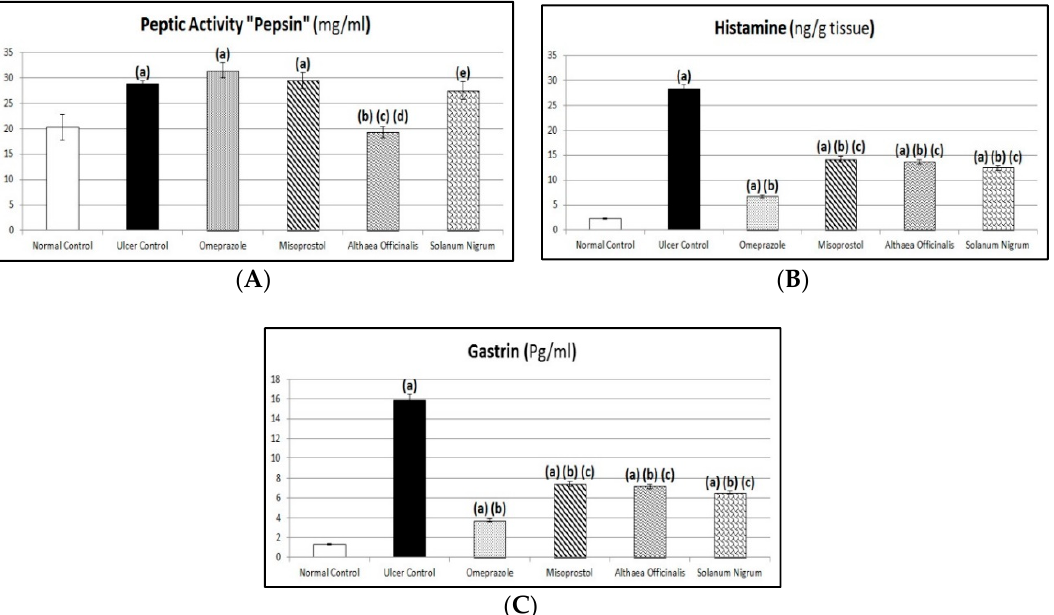
Figure 7. Protective effects of Althaea officinalis and Solanum nigrum with standards misoprostol and omeprazole on peptic activity ( A ), histamine ( B ), and gastrin ( C ) against pyloric-ligation/indomethacin-induced gastric-ulceration experimentally in male rats. Each value signifies the mean of 6–8 animals ± standard error of the mean. Statistical analysis was performed via one-way ANOVA test, and after that the Tukey–Kramer multiple comparisons test was done. Where: (a) indicates a significant difference from the normal control group ( p < 0.05), (b) indicates a significant difference from the gastric ulcer control group ( p < 0.05), (c) indicates a significant difference from the omeprazole (1st standard pretreatment) group ( p < 0.05), and (d) indicates a significant difference from the misoprostol (2nd standard pretreatment) group ( p < 0.05).